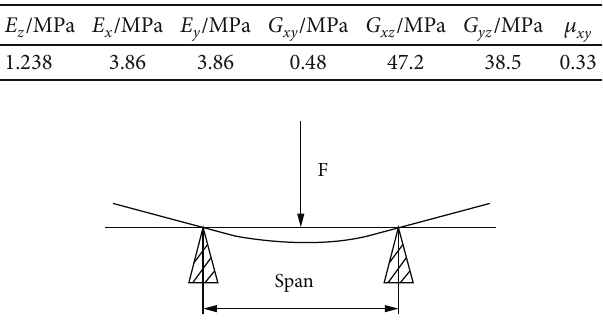
Table 3: Equivalent material parameters of honeycomb cores.